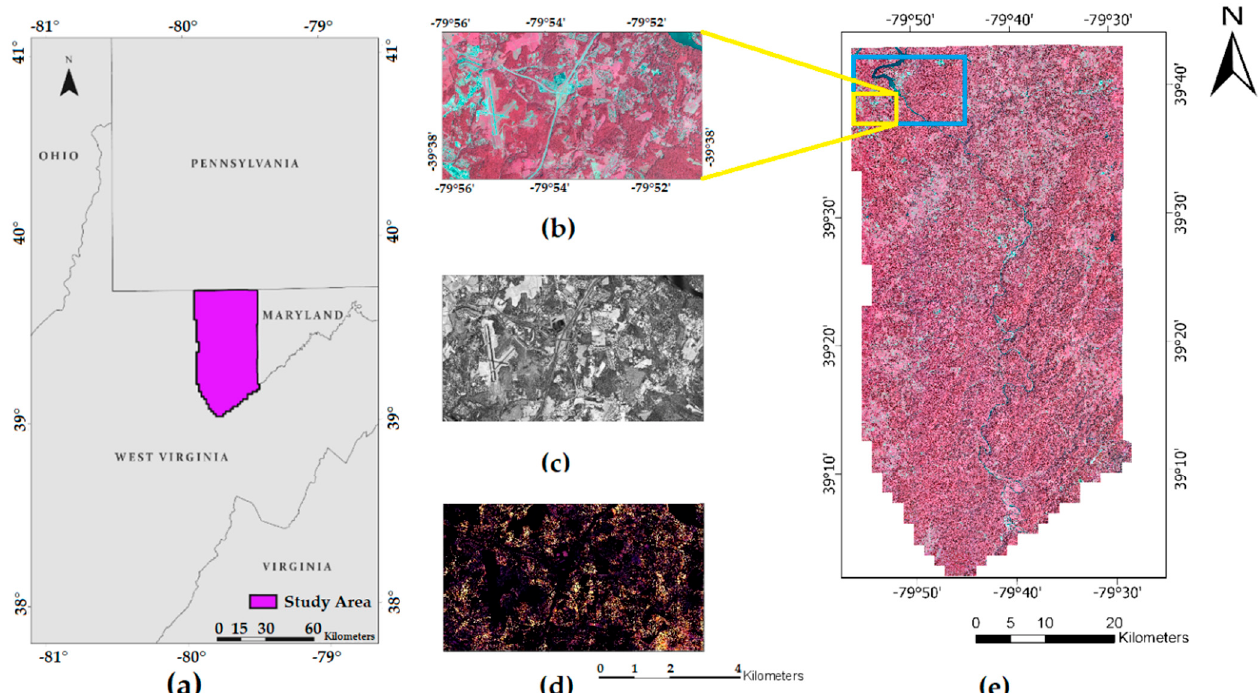
Figure 1. ( a ) Study Area in Northeastern, West Virginia, USA. ( b ) small subset area, showing 4-band color infrared NAIP Orthoimagery, displaying bands near-infrared (NIR), Red, Green as RGB, ( c ) LIDAR-derived Intensity nDSM, ( d ) LIDAR- derived normalized digital surface model (nDSM), ( e ) false color composite NAIP orthomosaic displaying bands NIR, Red, Green, as RGB, of the entire study area. Highlighted area in yellow indicates the subset area represented in this figure, area in blue refers to the subset area discussed in Section 3.2.